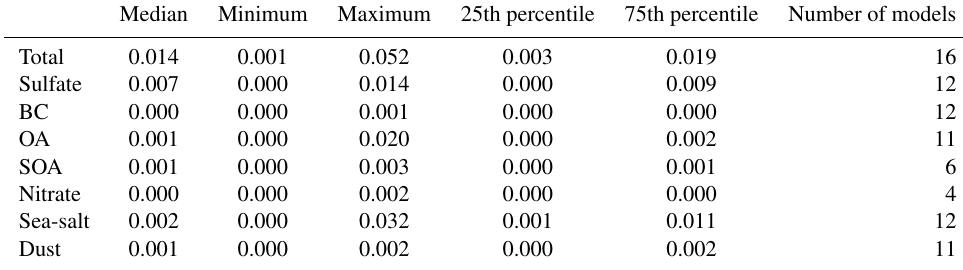
Table 4. As Table 3, but averaged over the Antarctic region (70–90 ◦ S).